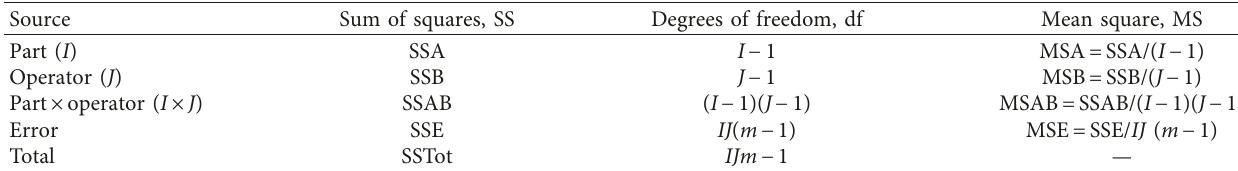
Table 5: Typical two-way ANOVA table for the R&R